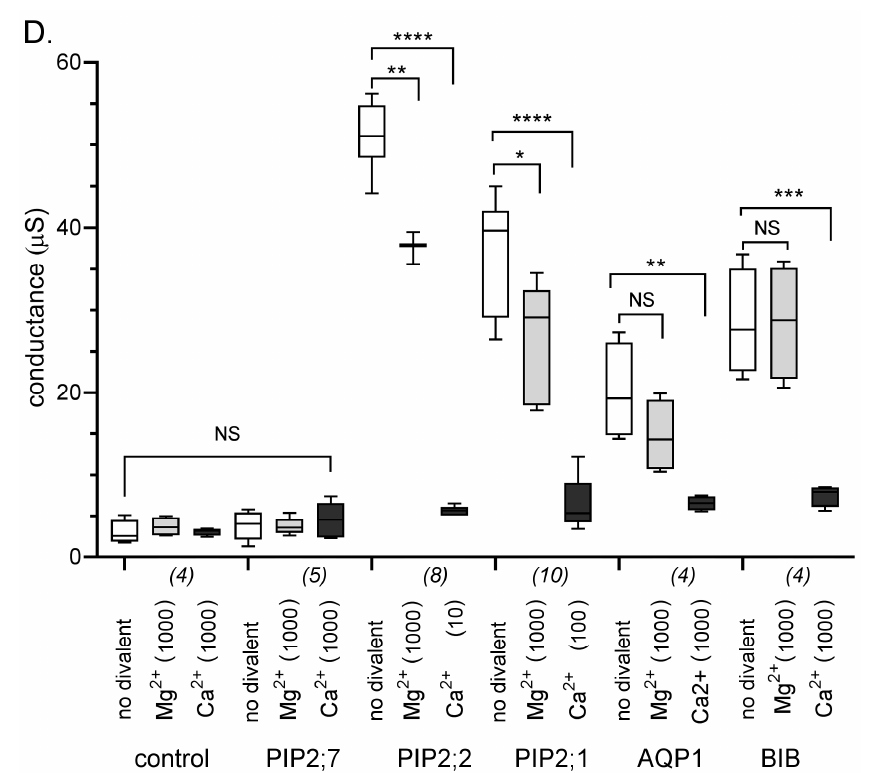
Figure 2. Effects of Mg 2+ and Ca 2+ divalent cations on ionic current responses in oocytes expressing different classes of AQPs. ( A ) Superimposed currents as a function of time measured by voltage clamp (steps from − 110 to +60 mV, from a holding potential of − 40 mV) at maximal activation in divalent-free saline ( left ), after application of Mg 2+ ( middle ), and after application of Ca 2+ ( right ). Control and PIP2;7-expressing oocytes lacked appreciable conductances. ( B ) Current-voltage relationships for the traces illustrated in ( A ). ( C ) Na + concentrations in oocytes expressing PIP2;2 as compared with control oocytes after incubation in Frog Ringers containing 96 mM NaCl for three days. Data are from four replicates; each replicate contained five oocytes. ( D ) Box plot summary of compiled data for the conductances. Free Ca 2+ concentrations are given in µ M. **** ( p < 0.0001); *** ( p < 0.001); ** ( p < 0.01); * ( p < 0.05); NS (not significant); using ANOVA with post-hoc Bonferroni tests. n values are in italics below the x